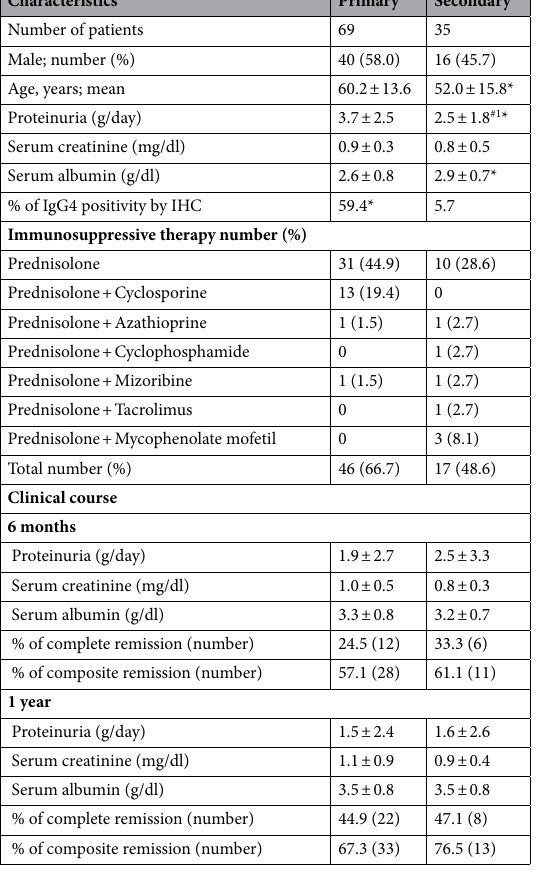
Table 1. Characteristics of primary and secondary MN patients at the time of renal biopsy and treatment response. # 1; a case did not check the level of proteinuria before renal biopsy. *p <